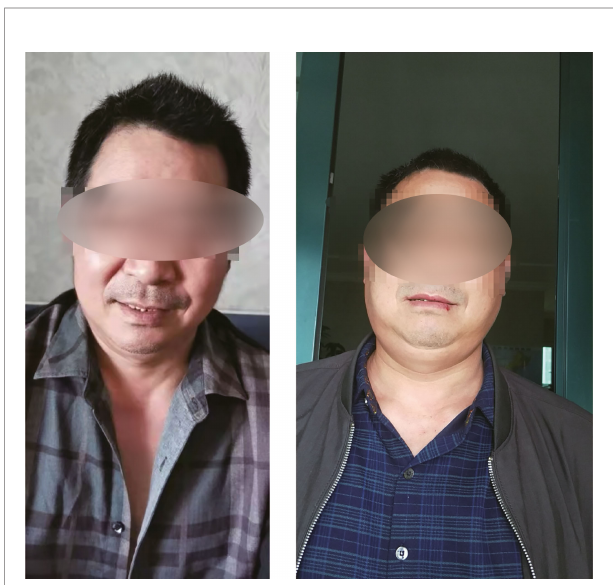
FIGURE 1 | Patient pictures. Left picture: Before treatment; Right picture: One month after